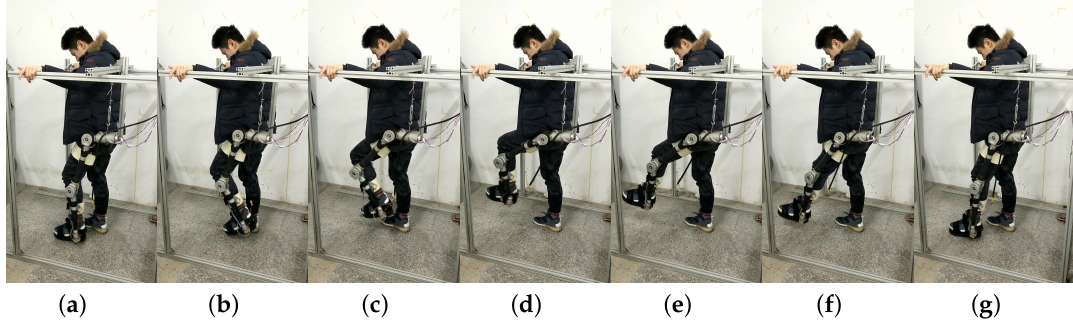
Figure 11. Flat walking experiment. ( a ) Initial ground contact; ( b ) heel rise; ( c ) initial swing; ( d ) middle swing; ( e ) terminal swing; ( f ) heel strike; ( g ) full ground contact. The interaction between the pilot and the exoskeleton is made possible with the compliant cuff. Moreover, the pilot is asked to naturally sway his left leg.